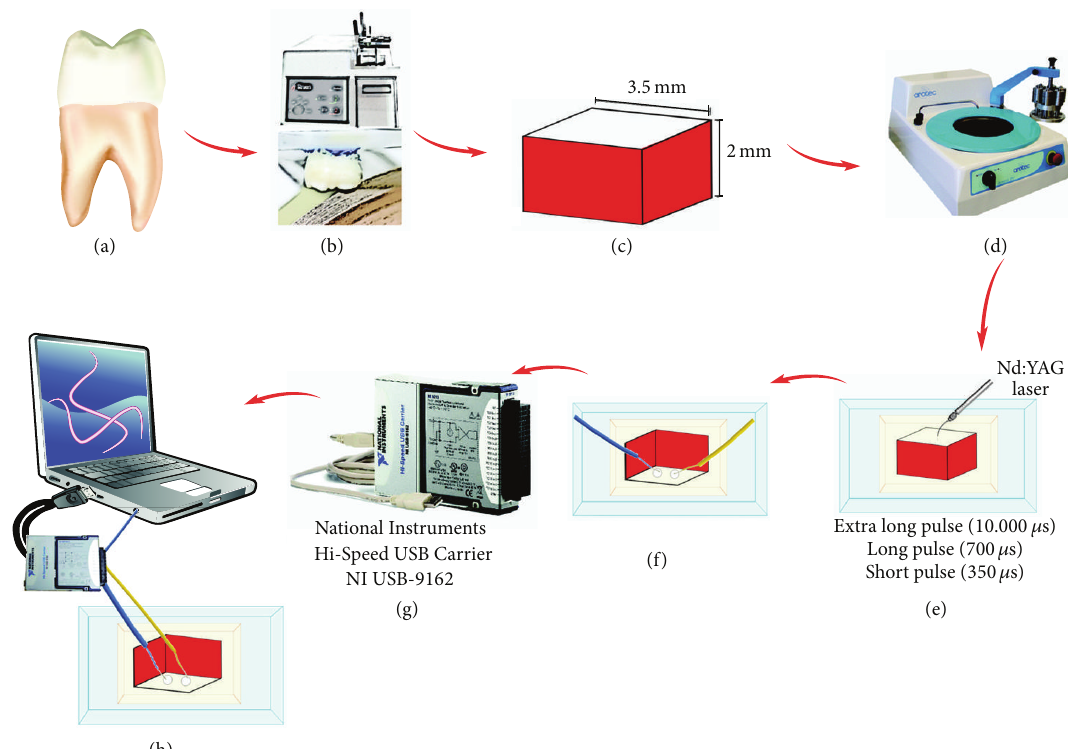
Figure 1: Schematic design of the employed methodology. (a) Primary molar; (b) section machine and sectioned tooth; (c) specimens (3.5 × 3.5 × 2.0 mm); (d) polisher; (e) fixation of specimens at acrylic plates, delimitation of irradiated area with insulating tape (4.0 mm 2 ), and irradiation with Nd:YAG laser; (f) holes to accommodate thermal-sensors (0.1mm depth); (g) acquisition plate; (h) system connected to the computer.